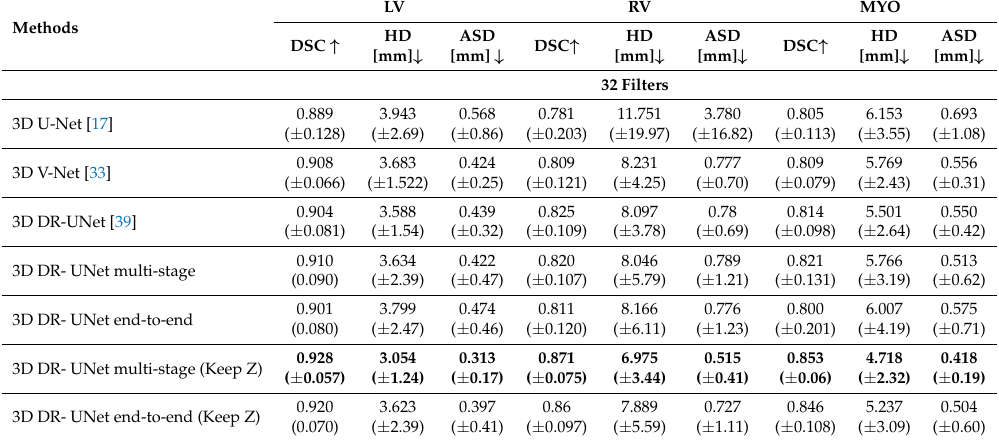
Table 4. Structure-wise DSC, HD and ASD scores (mean ± (std)) for the right ventricle (RV), left ventricle (LV) and myocardium (MYO) from the ACDC dataset.